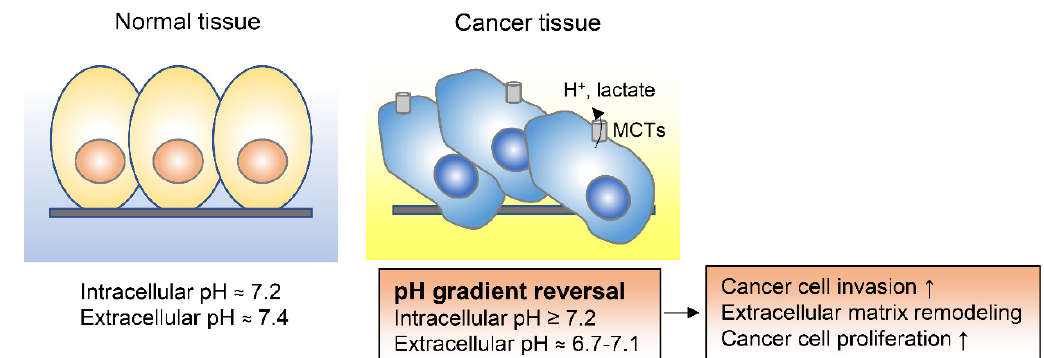
Figure 4. Adaptation to the extracellular acidification of tumor microenvironments. Cancer cells have reversed pH gradient compared to normal tissue which is achieved by monocarboxylate transporters (MCTs). The reversed pH gradient could enhance cancer cell invasion and proliferation.